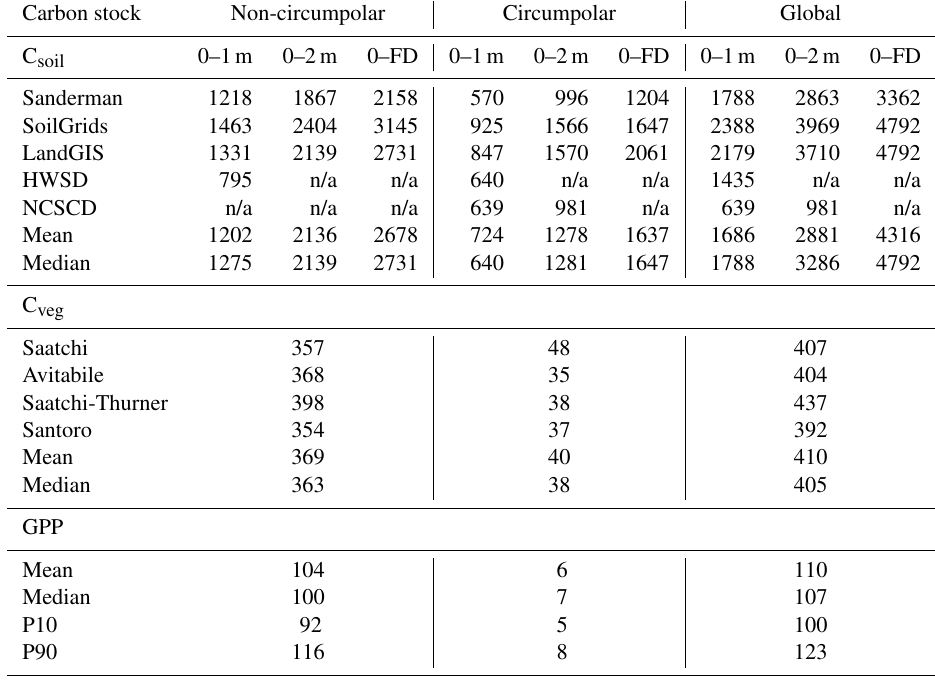
Table 2. Estimates of soil organic carbon stocks (PgC), vegetation biomass (PgC) and GPP (PgCyr − 1